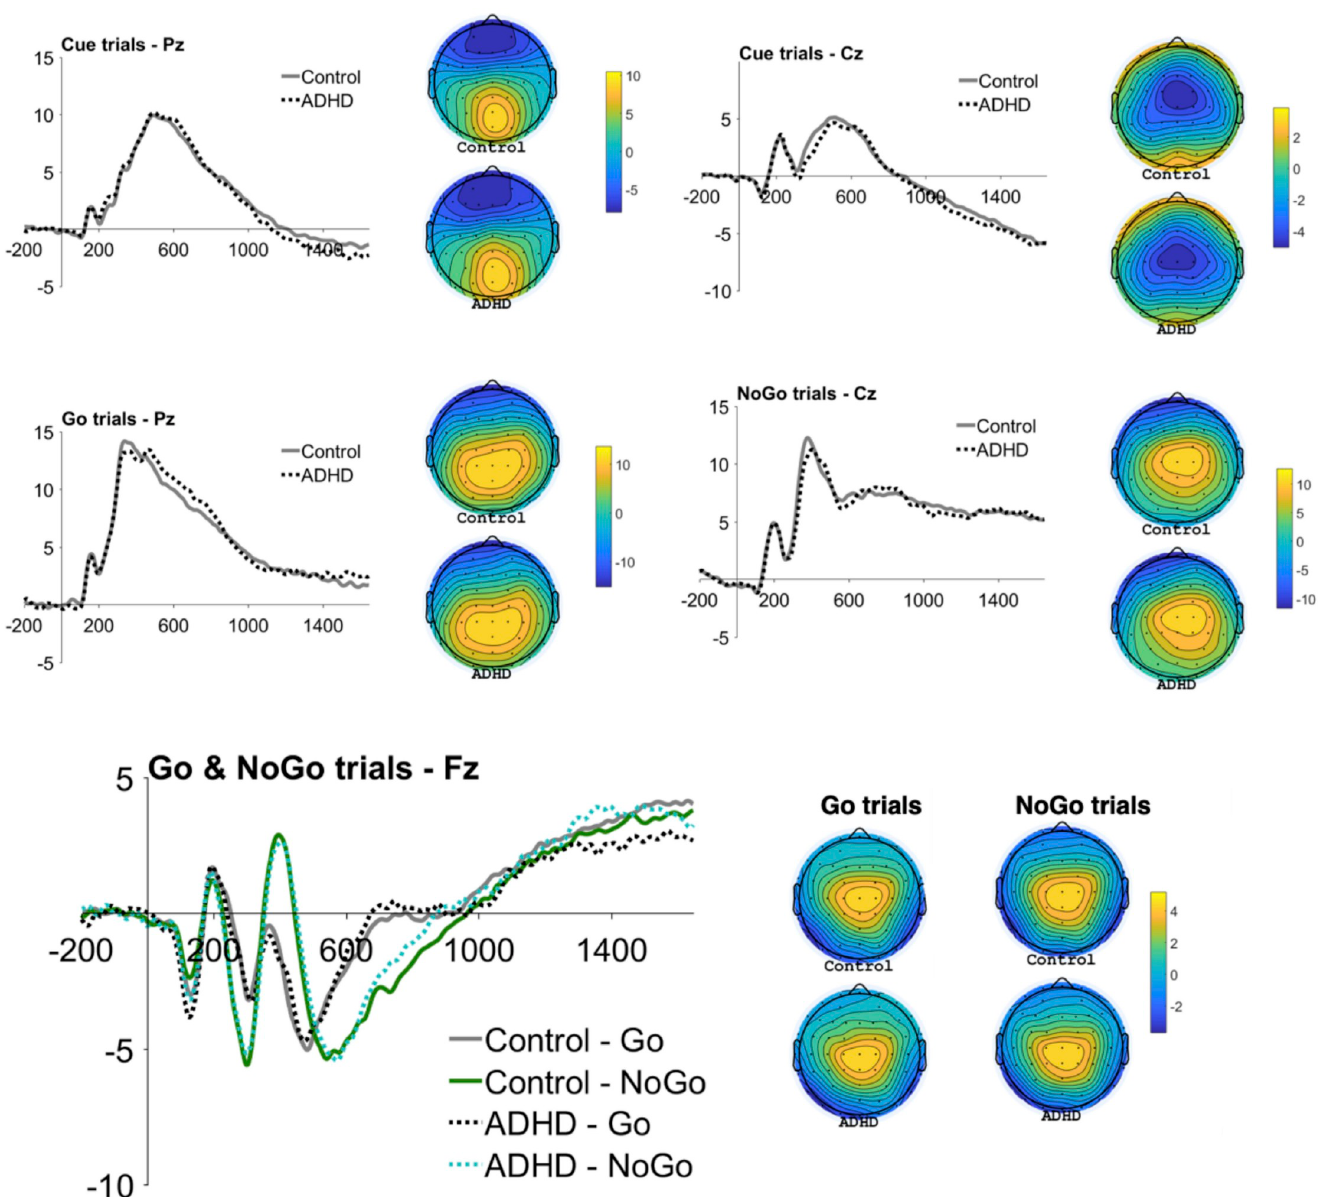
Fig 1. Grand mean event-related potentials (ERPs) to cue stimuli at Pz (for P3) and Cz (for CNV), to go stimuli at Pz (for P3) and Fz (for N2), and to nogo stimuli at Cz (for P3) and Fz (for N2), and the corresponding topographic maps by group.